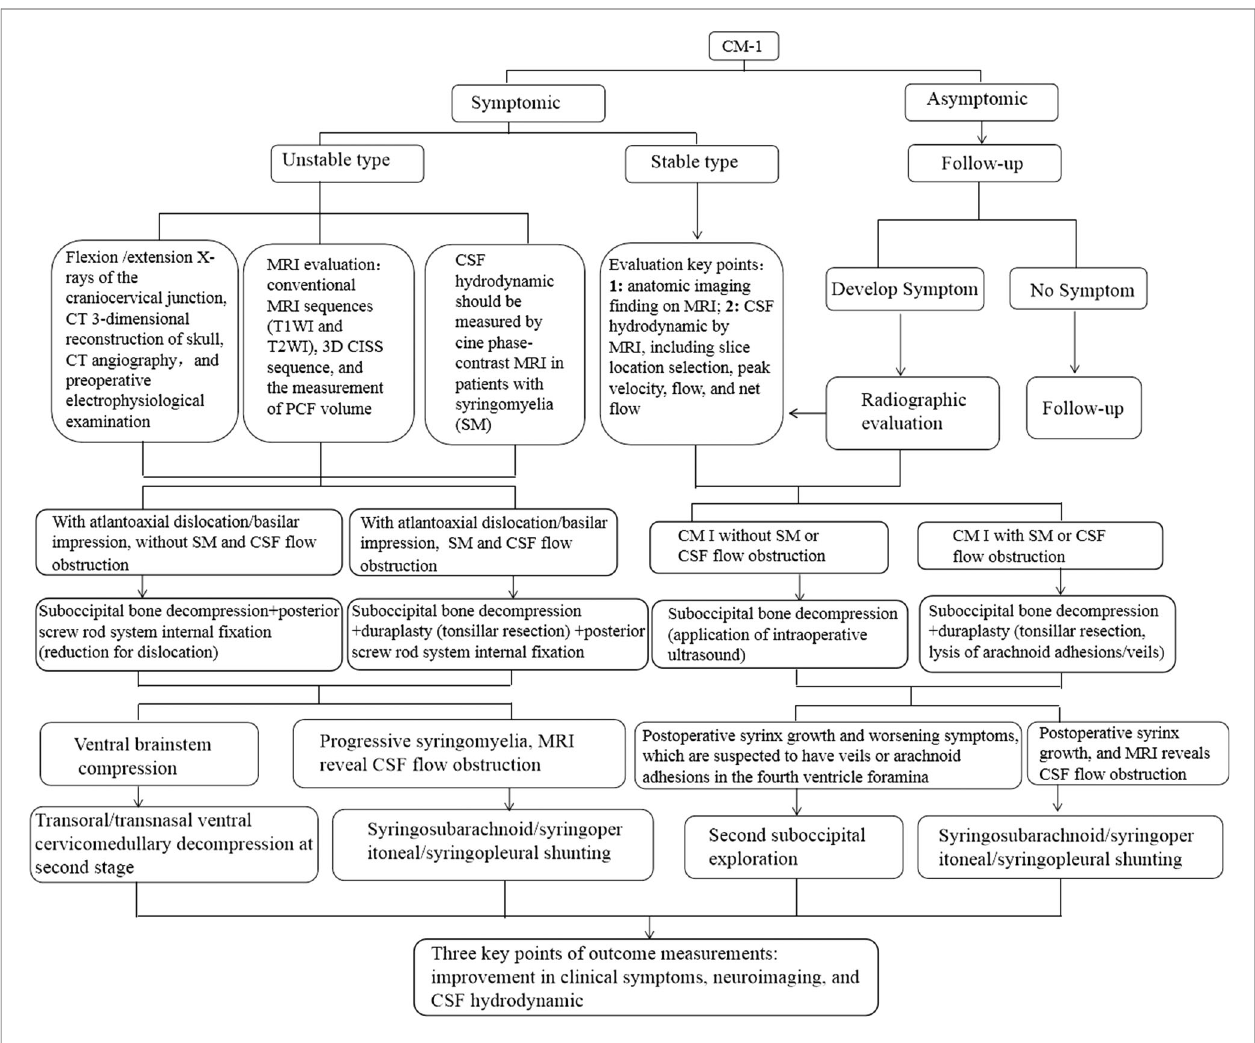
FIGURE 4 | Algorithm fl